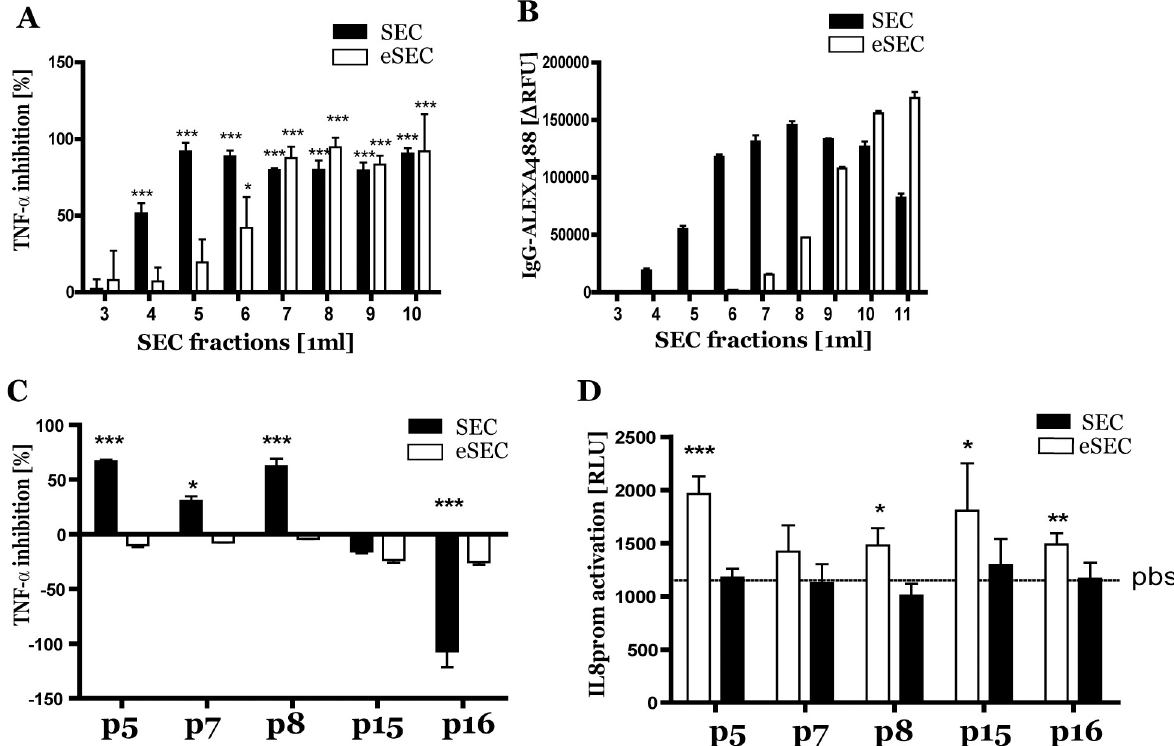
Fig 5. No TNF- α inhibition and IL8 promoter activation by eSEC isolated pEVs. Comparison of SEC vs eSEC isolation. Etanercept (1 μ g/ml) in the presence of 500 μ l pfp was isolated and TNF- α inhibition of each eluted SEC (black bars) or eSEC (white bars) fraction was determined using a TNF- α sensitive reporter bioassay (A). Also Alexa488 labelled IgG (1 μ g/ml) was SEC (black bars) or eSEC (white bars) isolated and in each fraction Alexa488 was measured by fluorometry (B). From 5 RA patients administered with etanercept pEVs were isolated by SEC (black bars) or eSEC (white bars) and TNF- α inhibition was determined (C). Direct biological effects of these isolated pEVs were studied in THP1 cells with an IL-8 promoter driven-firefly luciferase expression construct (D). Statistically significant differences were determined by Mann-Whitney test versus control (for A and D only TNF- α without pEVs and for E only pbs) or by paired T-test (C), � p < 0.05, �� p < 0.01, ��� p < 0.001.